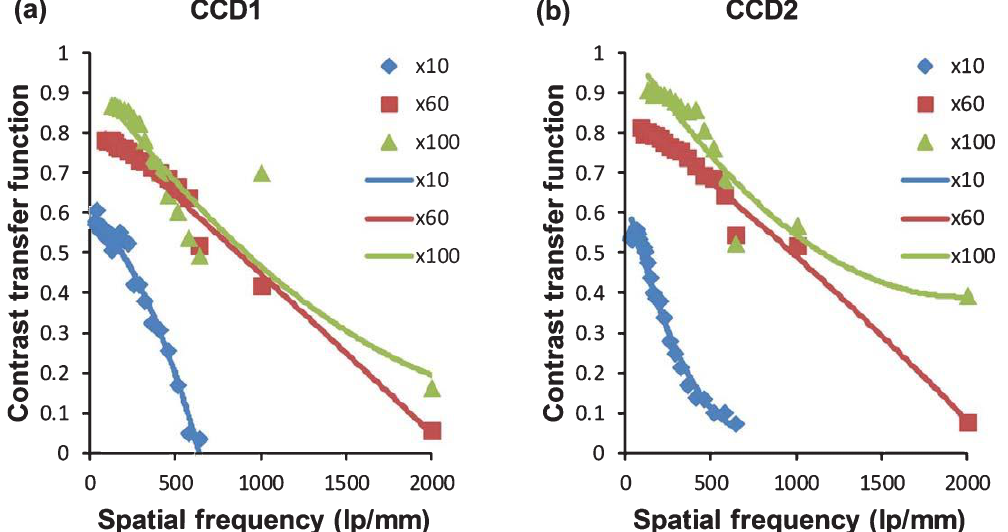
Fig. 6. Contrast transfer function (CTF) curves of the two CCD detectors. Two high resolution targets, USAF 2”X2” NEG (up to 645lp/mm, Edmund Industrial Optics, USA) and MRS-4 (up to 2000lp/mm, Geller, USA), are imaged under the 10 × and 60 × objective lenses and the 100 × oil objective lens, respectively. Each curve corresponds to an objective-CCD